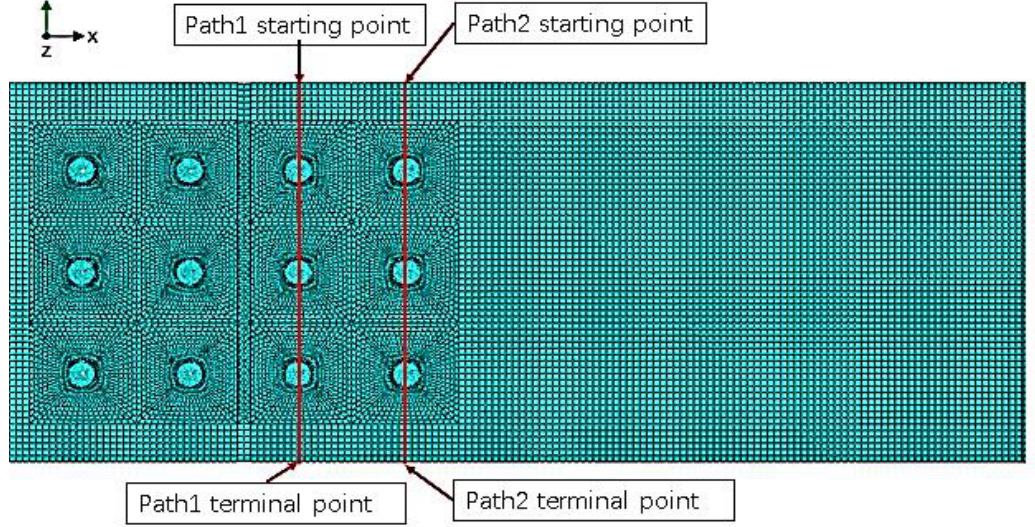
Figure 7. Meshing of model with the strap butt joints.